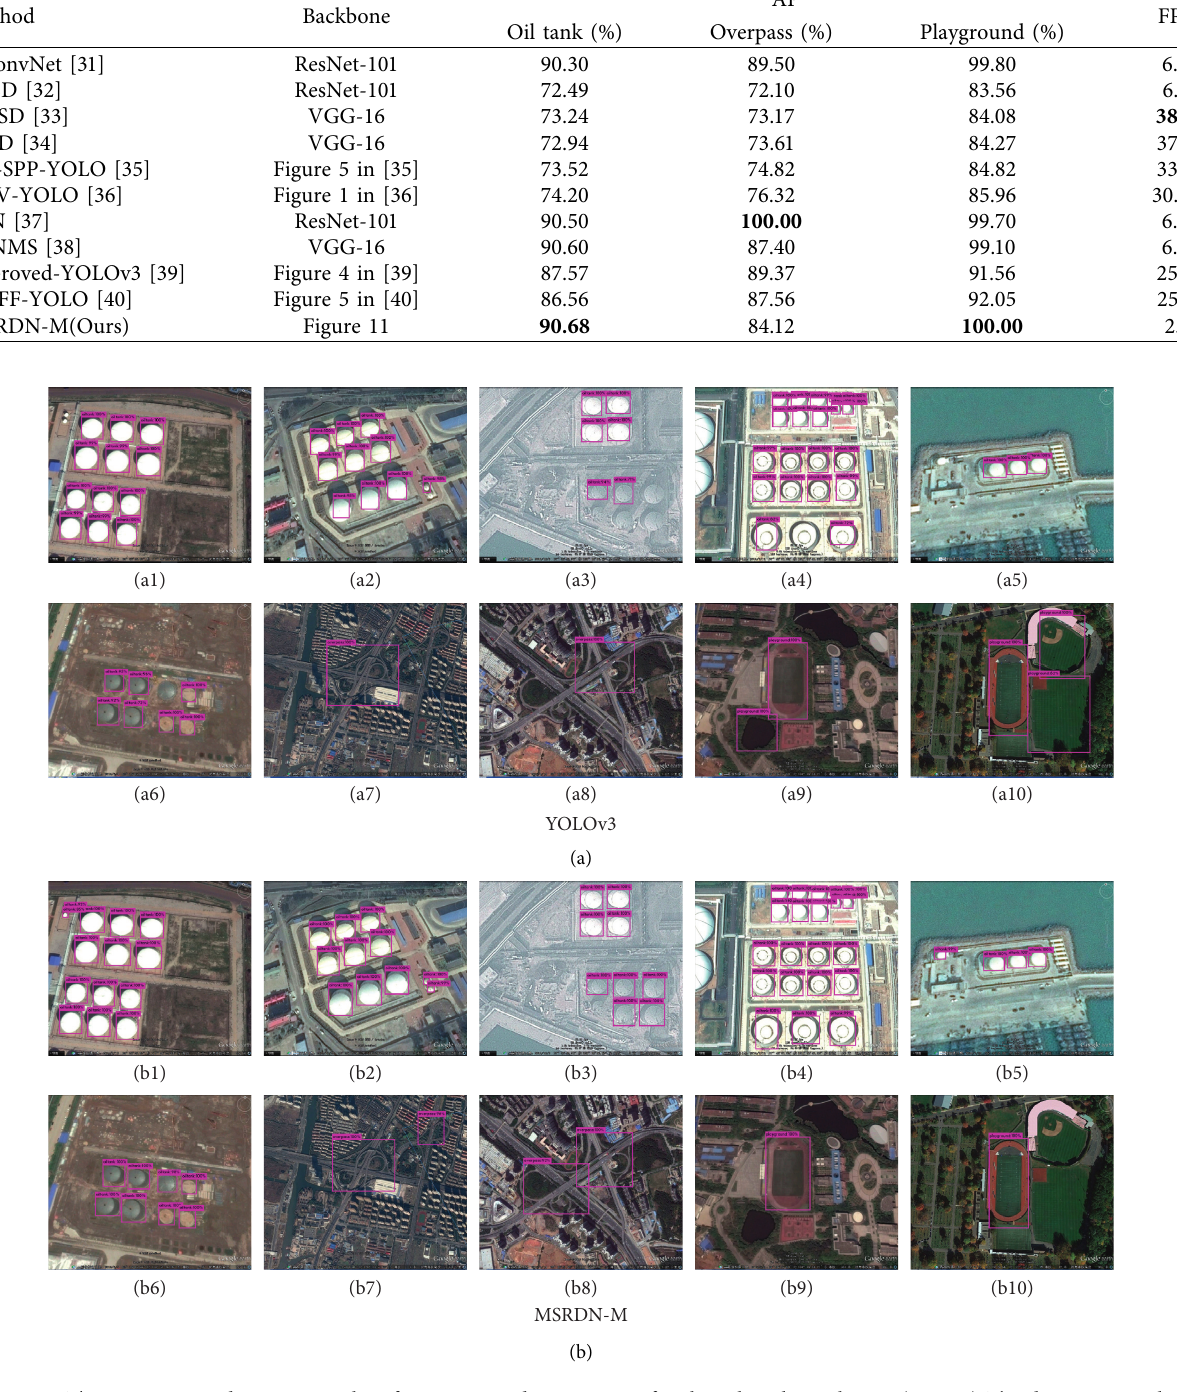
Figure 18: The comparison detection results of YOLOv3 and MSRDN-M for the other three classes. (a1–a10) The detection results of YOLOv3. (b1–b10) The detection results of MSRDN-M for the